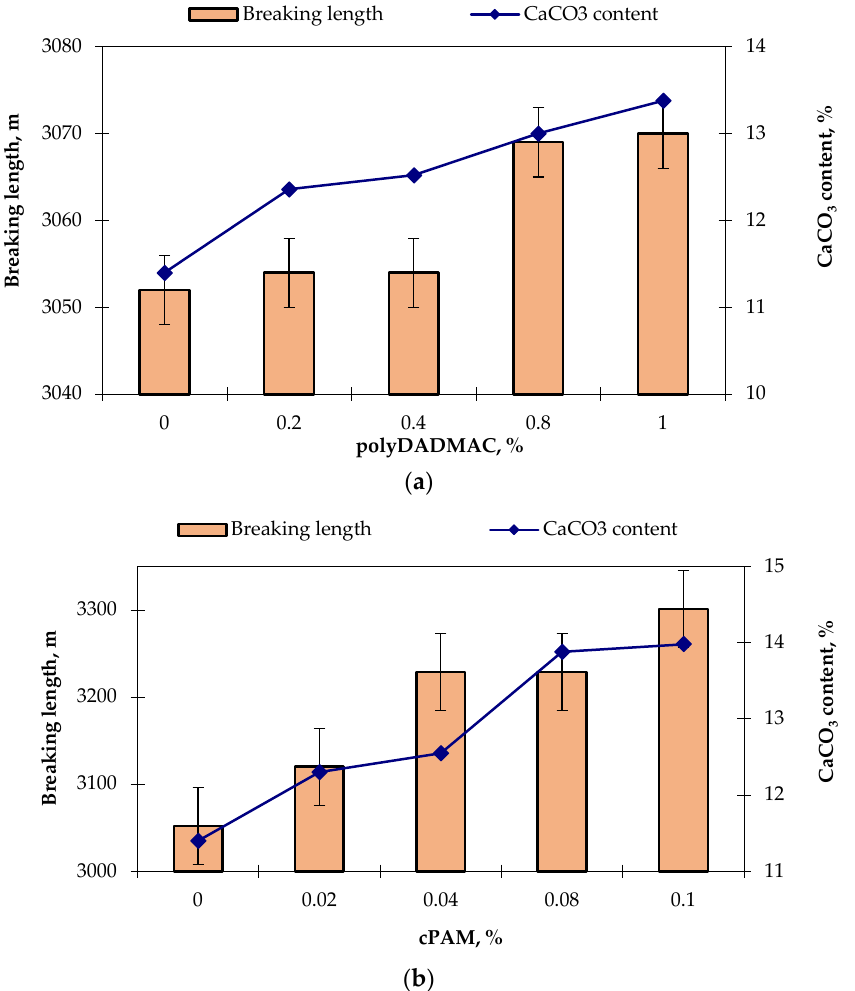
Figure 7. Influence of addition of polyDADMAC ( a ) and cPAM ( b ) on break length of the paper loaded with PPC.